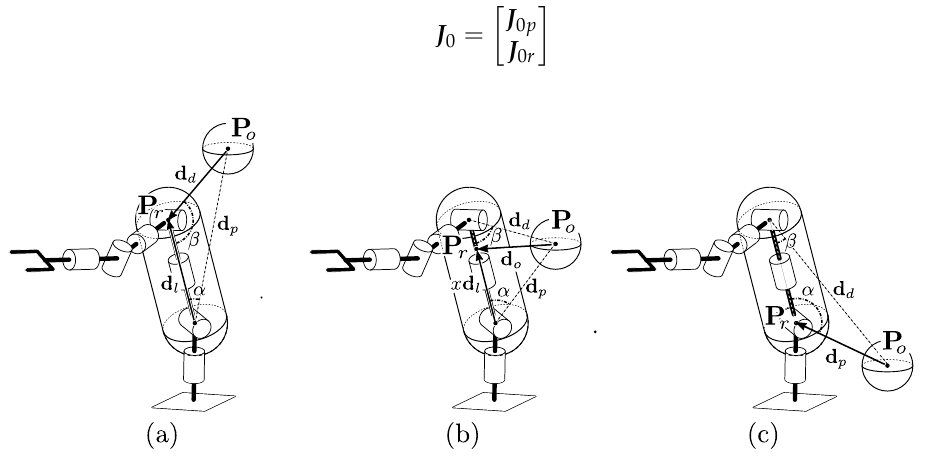
Figure 1. Obstacle-link distance calculation; cases ( a – c ) refer to Equations (4)–(6)